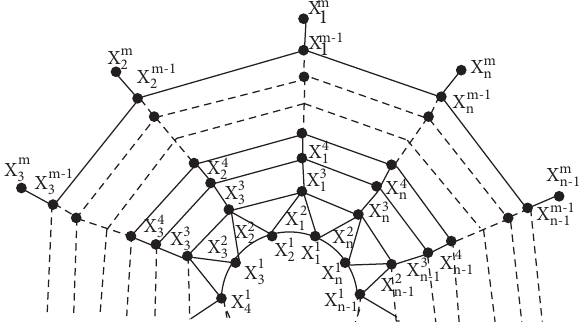
Figure 1: The generalized convex polytope graph S p